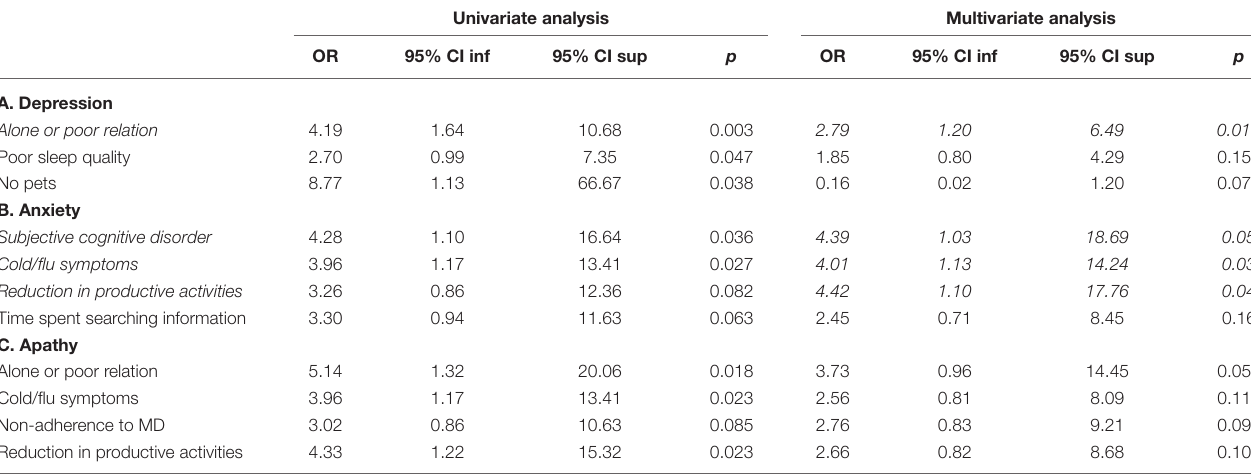
TABLE 4 | Univariate and multivariate analyses of factors which resulted associated with depression, anxiety and